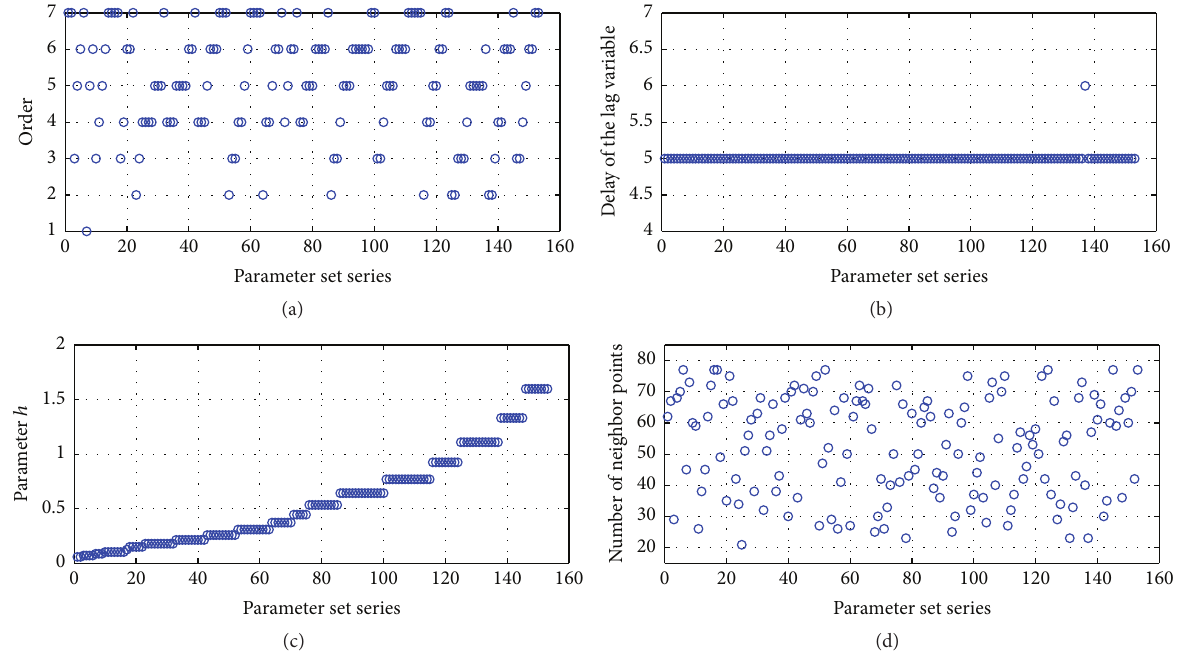
Figure 3: Results of Lorenz time series’ multistep prediction: (a) the functional coefficients’ order; (b) the delay of the lag variable ( 𝑦 - coordinate value 𝑦 is equivalent to (𝑦 − 1)𝜏 ); (c) the weight parameter; (d) the number of nearest neighbor points (equivalent to number- 2𝑚(𝑟+1) ). Note: for Figure 4, the delay of the lag variable and the number of nearest neighbor points are the same as this figure, respectively.